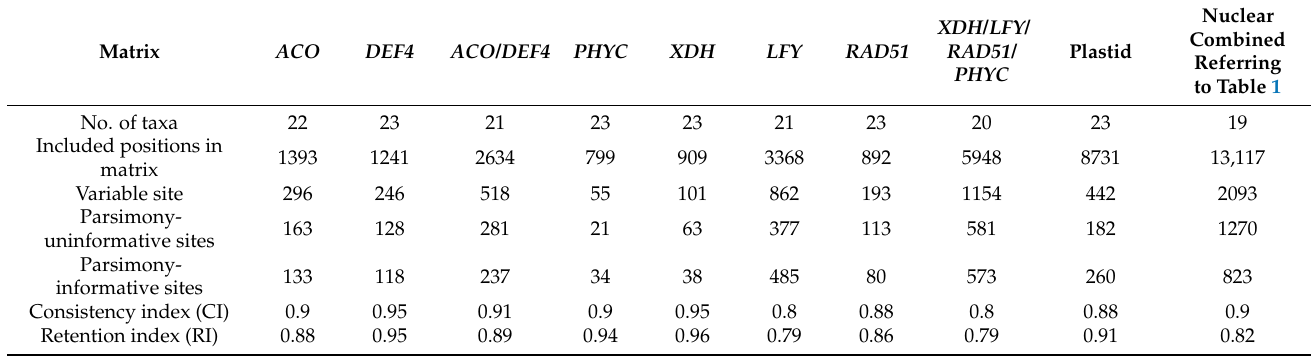
Table 2. Statistics of one of the parsimonious